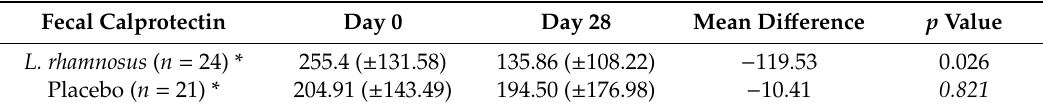
Table 4. Descriptive variable of fecal calprotectin (media, ± standard deviation), µ g / g, in infant with colic at enrolment and after 28 days of subjects supplementated with L. rhamonosus or placebo. Fecal Calprotectin Day 0 Day 28 Mean Di ff erence p